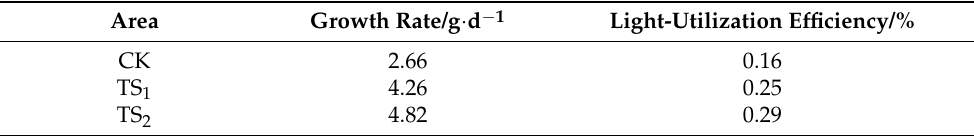
Table 5. Effects of WCTRZSCS on tomato growth rate and light-utilization